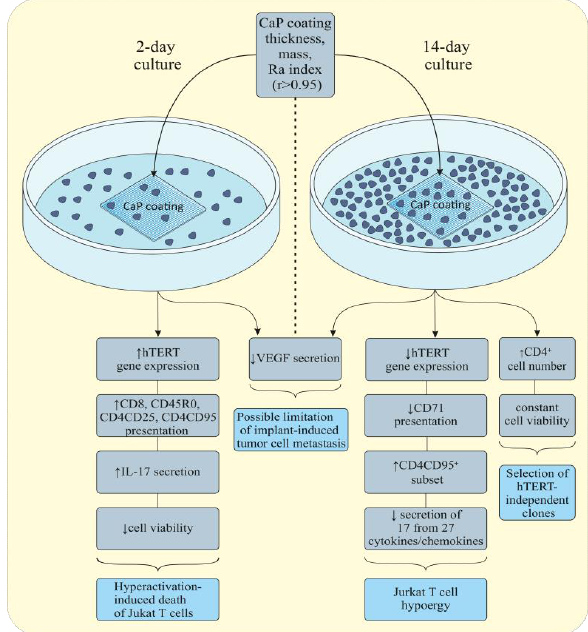
Figure 7. Variable reactions of Jurkat T cells induced by rough microarc CaP-coated titanium substrates in short-term and long-term